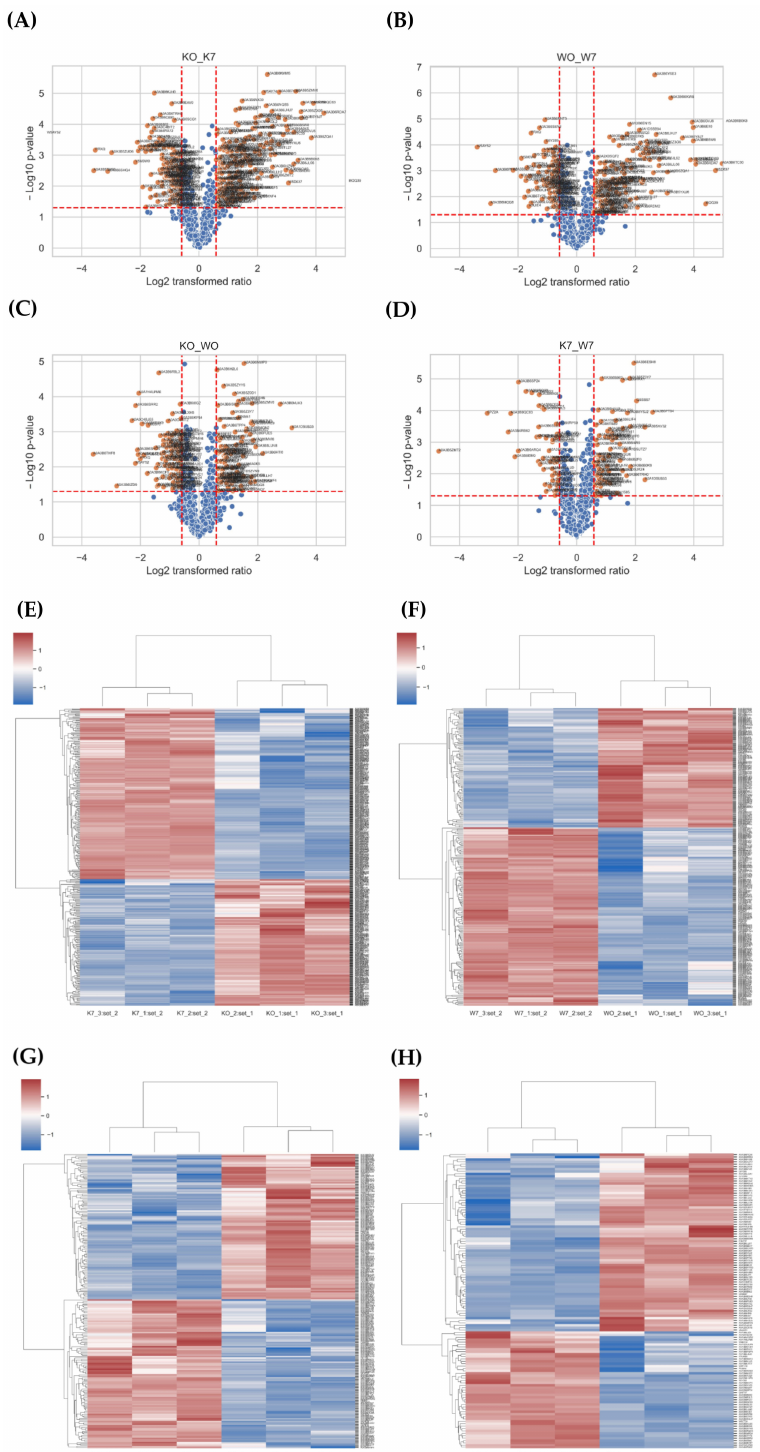
Figure 5. Volcano plot and heatmap analysis of differentially expressed proteins (DEPs) in K0 vs. K7, W0 vs. W7, K0 vs. W0, and K7 vs. W7 groups. ( A ) Volcano plot of the K0 vs. K7 group, ( B ) volcano plot of the W0 vs. W7 group, ( C ) volcano plot of the K0 vs. W0 group, ( D ) volcano plot of the K7 vs. W7 group, ( E ) heatmap analysis for DEGs in K0 vs. K7 group, ( F ) heatmap analysis for DEGs in the W0 vs. W7 group, ( G ) heatmap analysis for DEGs in the K0 vs. W0 group, and ( H ) heatmap analysis for DEGs in the K7 vs. W7